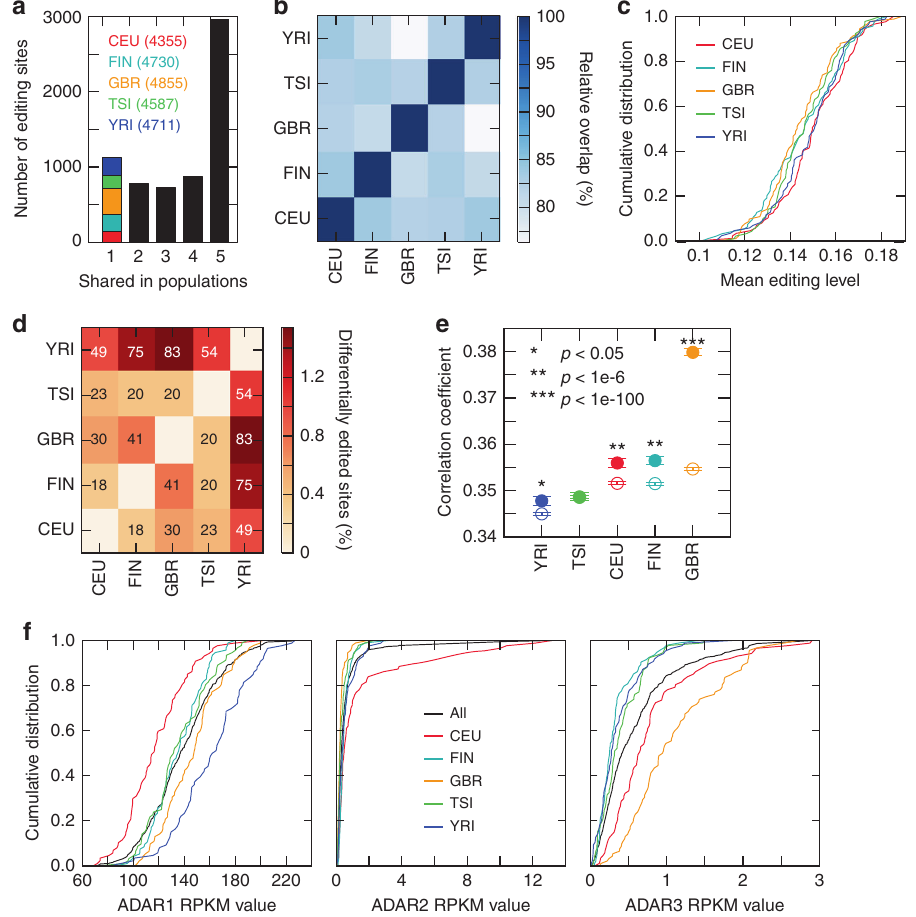
Fig. 3 Comparison of editomes across populations. a Number of A-to-I editing sites shared between populations. Editing sites speci fi c to one population are color-coded. The total number of editing sites included for each population is shown in parenthesis. b Overlap of editing sites between a pair of populations. Percentages calculated relative to the number of editing sites in the population with the smaller total number of sites. The overlap was signi fi cant ( p < 1e-20, Hypergeometric test) for all comparisons. c Cumulative distributions of average editing levels (per individual) in different populations. d Percentage of differentially edited sites between a pair of populations ( p < 0.01, Wilcoxon Rank-Sum test, see Methods), relative to the total number of testable sites in each pairwise comparison. The number of differentially edited sites is indicated in each grid. e Correlation coef fi cients of editing levels in two individuals from the same population ( fi lled circles) and of two individuals from different populations (with one individual from the indicated population, the other from any other population, empty circles). Mean and standard error are shown. P values are shown to compare the difference between intra- and inter-population correlations (Wilcoxon Rank-Sum test). f ADAR expression levels in different